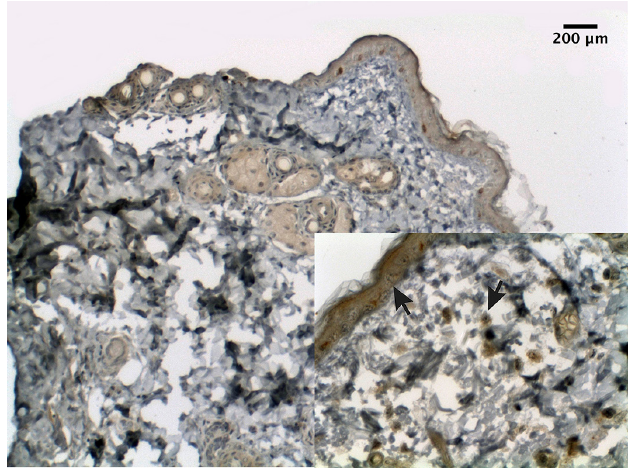
FIGURE 9 - Photomicrograph of immunohistochemical iNOS detection in male mouse skin. Skin of group 4 mice treated with 10% L-arginine marked by positive immunohistochemical iNOS staining in the epithelial cells, connective tissue, and cutaneous annexes (x100, detail